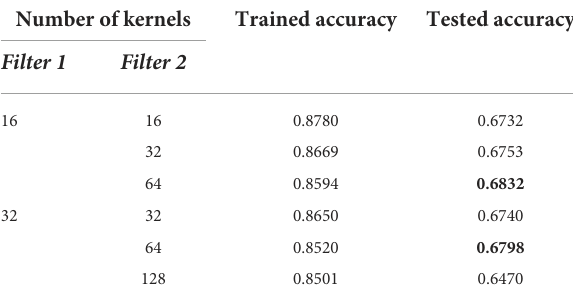
TABLE 8 Comparison of experimental results with different numbers of kernel.